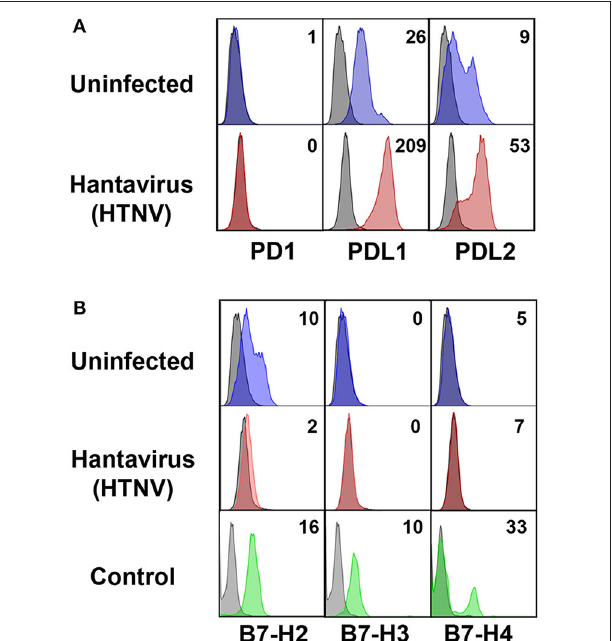
FIGURE 3 | Hantavirus-induced upregulation of PD-L1 and PD-L2 on immature DCs. (A) Immature DCs were infected with HTNV at a MOI of 1.5 and incubated for 4 days before staining for PD-1, PD-L1 or PD-L2. (B) Immature DCs infected as for (A) were stained for members of the B7 family other than PD-L1/PD-L2. The results shown are representative of three independent experiments using three different donors. Positive controls are given in the lower panel (B7-H2 and B7-H3 from HUVEC, B7-H4 from HEK293 cells transfected with a B7-H4 plasmid).